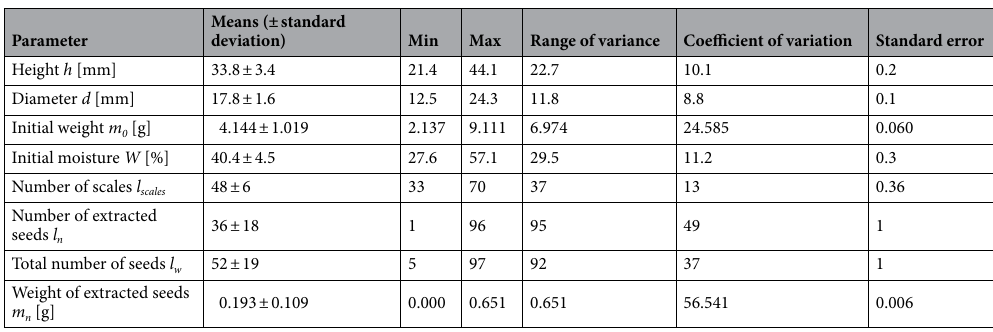
Table 2. Cone and seed parameters for the entire study